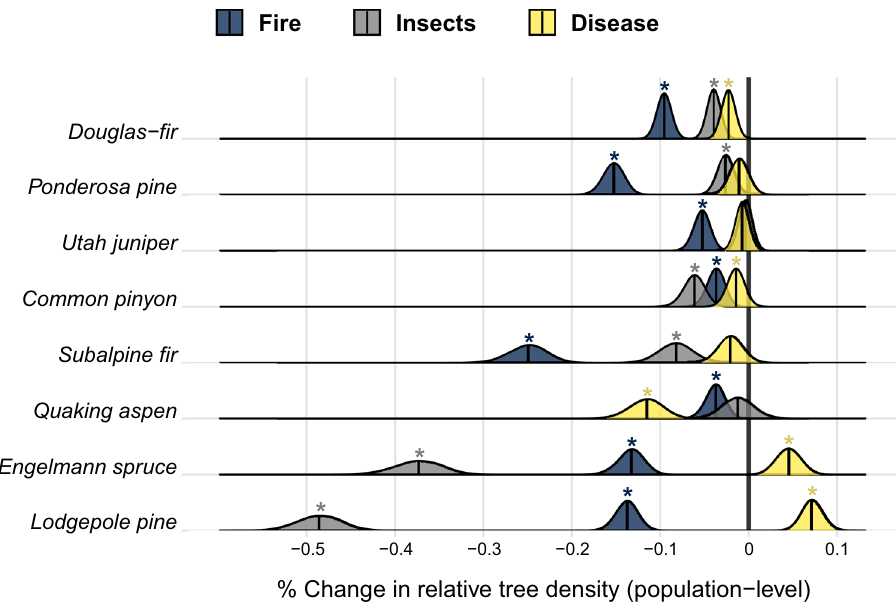
Fig. 5 Posterior distributions of the estimated effects of forest disturbances on the relative density of live tree populations for the eight most abundant species in the western US over the period 2001 – 2018. Change in relative tree density resulting from each disturbance type is estimated as the product of average disturbance severity and probability (annual), where disturbance severity is de fi ned as the average difference in relative density shifts between undisturbed and disturbed sites. Posterior probability distributions of parameters are estimated via Markov chain Monte Carlo (5000 samples). Posterior medians of each parameter are plotted as black vertical lines. Asterisks indicate the 95% credible interval of the mean effect excludes zero, and hence are considered statistically signi fi cant. Source data are provided as a Source Data fi